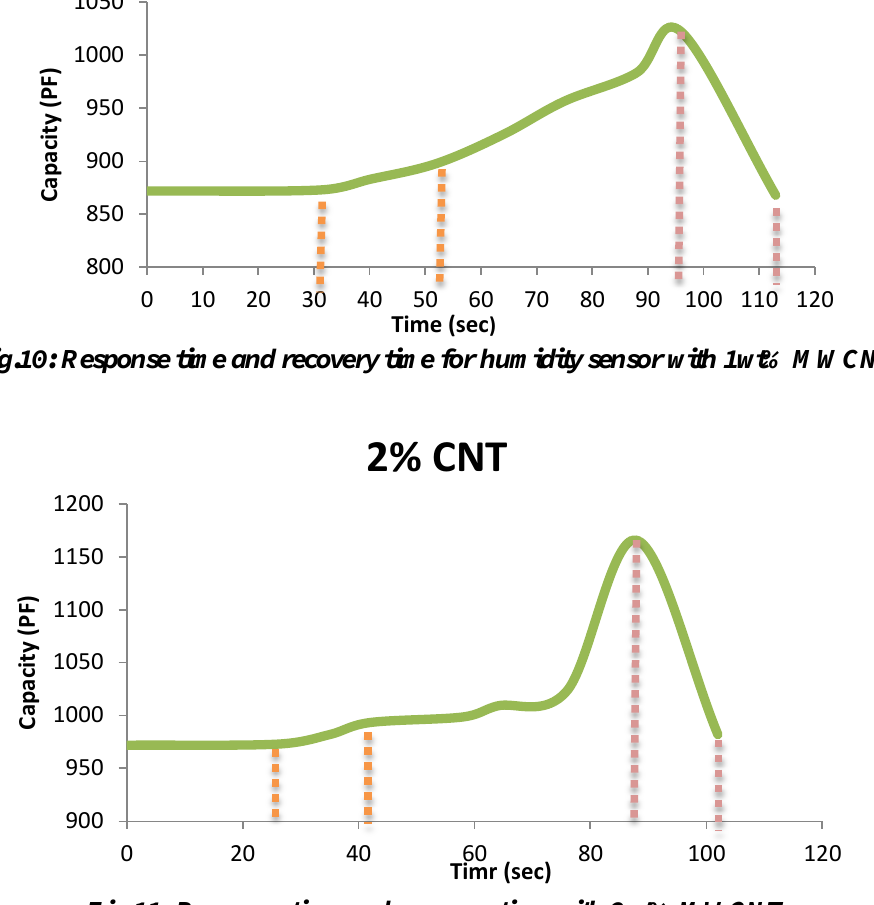
Fig.11: Response time and recovery time with 2wt%